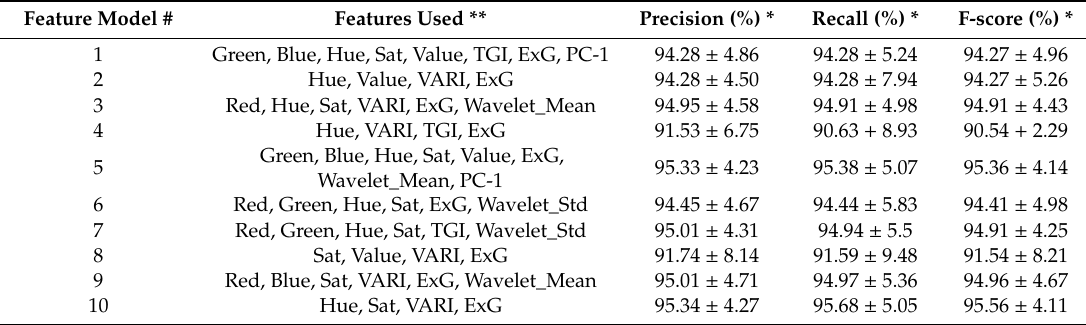
Table 3. Validation samples-based accuracy statistics for 10 best feature models used for detecting Italian ryegrass in wheat. The 10 best feature models were determined through the exhaustive feature selection process. The accuracy statistics for each feature model were based on 250 samples for each user-defined